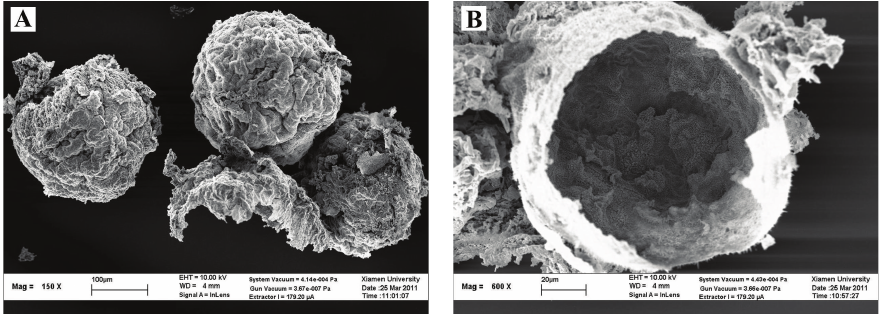
F 9: SEM images of hollow magnetic CS microcapsules aer